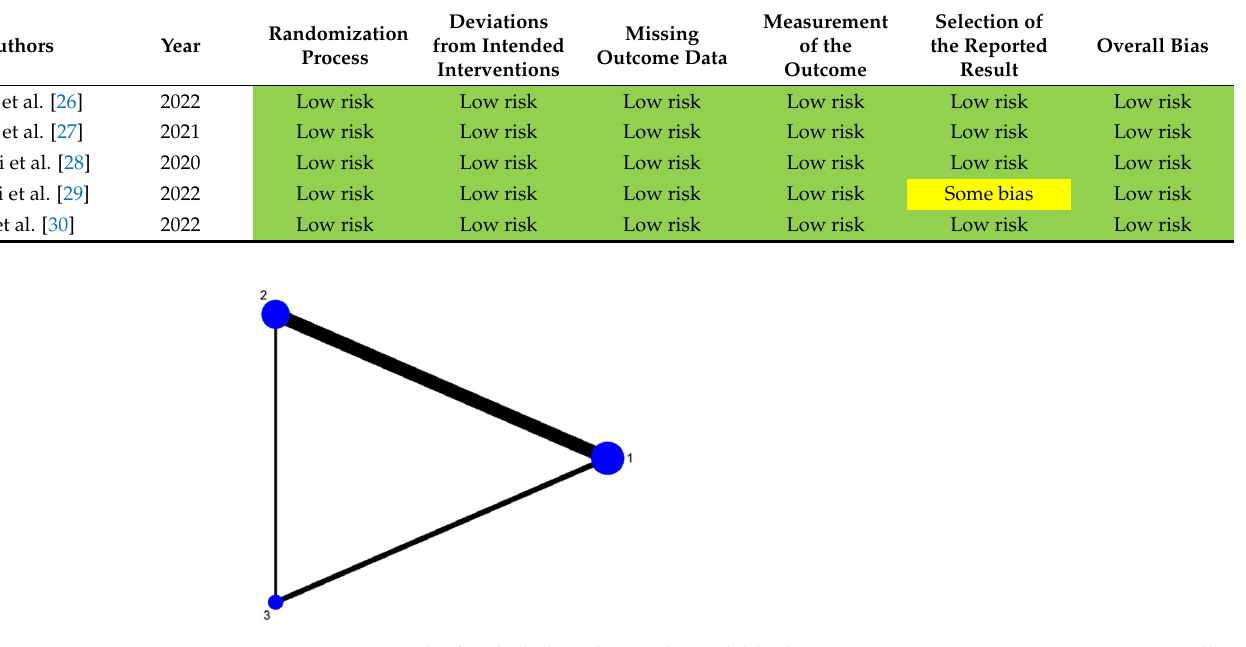
Figure 2. Network of included studies with available direct comparisons. 1. Vonoprazan-amoxicillin; 2. vonoprazan-amoxicillin-clarithromycin; 3. PPI-amoxicillin-clarithromycin. Table 3. SUCRA-based efficacy ranking league matrix showing the comparative efficacies of the regimens included in this Network